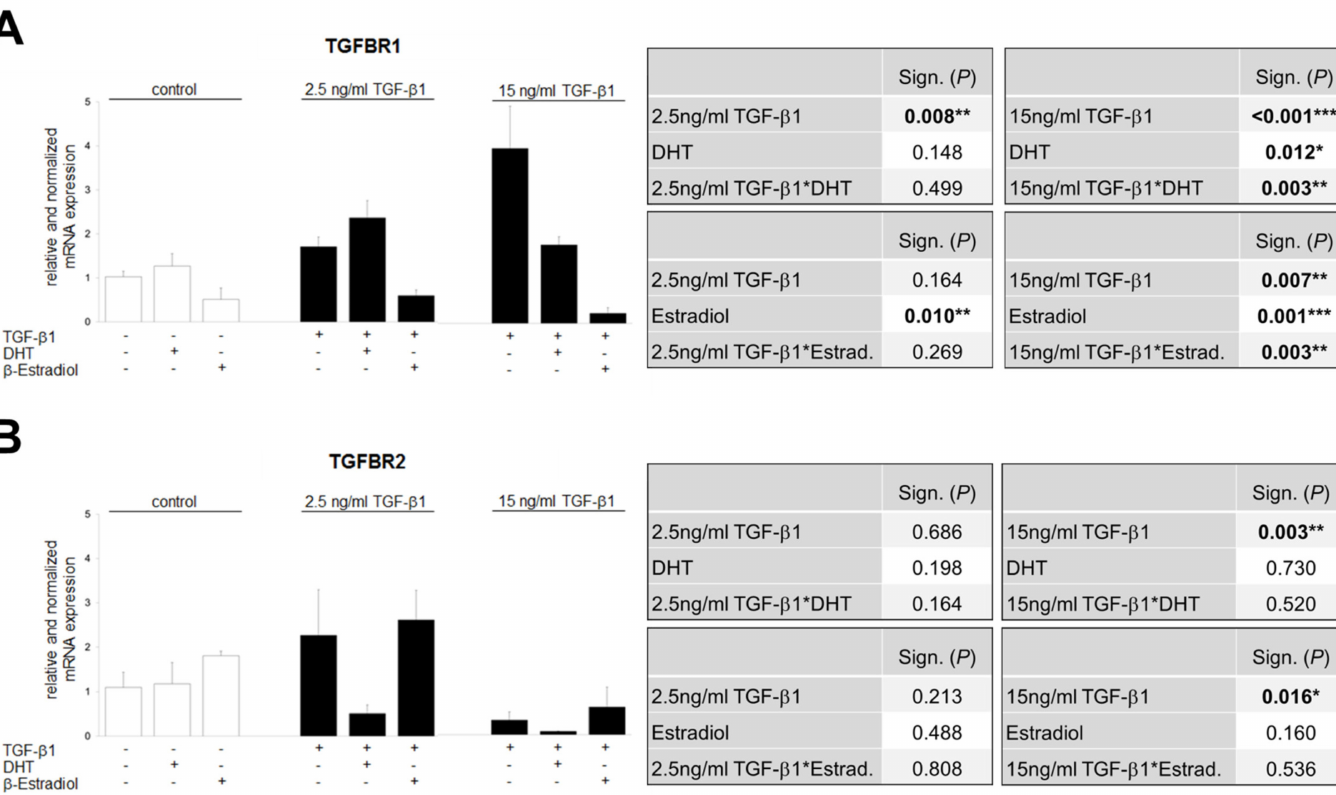
Figure 8. E ff ect of TGF- β 1 on expression of TGF- β 1 receptor 1 and 2 in TKPTS cells. ( A ) TGFBR1 mRNA analysis. Cells were stimulated for 24 h with TGF- β 1 (control or 2.5 or 15 ng / mL) and with or without sex hormones (DHT / β -estradiol), as indicated ( n = 4 / 6 / 2 / 6 / 6 / 2 / 2 / 5 / 3). ( B ) TGFBR2 mRNA analysis. Cells were stimulated for 24 h with TGF- β 1 (control or 2.5 or 15 ng / mL) and with or without sex hormones (DHT / β -estradiol), as indicated ( n = 3 / 3 / 2 / 3 / 3 / 3 / 4 / 5 / 3). ( A , B ) The significances, shown in the upper tables, were assessed using two-way ANOVA with TGF- β 1 (control or 2.5 (left table) or 15 ng / mL (right table)) and DHT as the two factors. The significances, shown in the lower tables, were assessed using two-way ANOVA with TGF- β 1 (control or 2.5 (left table) or 15 ng / mL (right table)) and estradiol as the two factors. TGF- β 1, DHT, Estradiol: main e ff ect of TGF- β 1 / DHT / Estradiol, respectively. TGF- β 1*DHT, TGF- β 1*Estradiol: interaction (determines whether the one main e ff ect depends on the level of the other main e ff ect). * P ≤ 0.05; ** P ≤ 0.01; *** P ≤